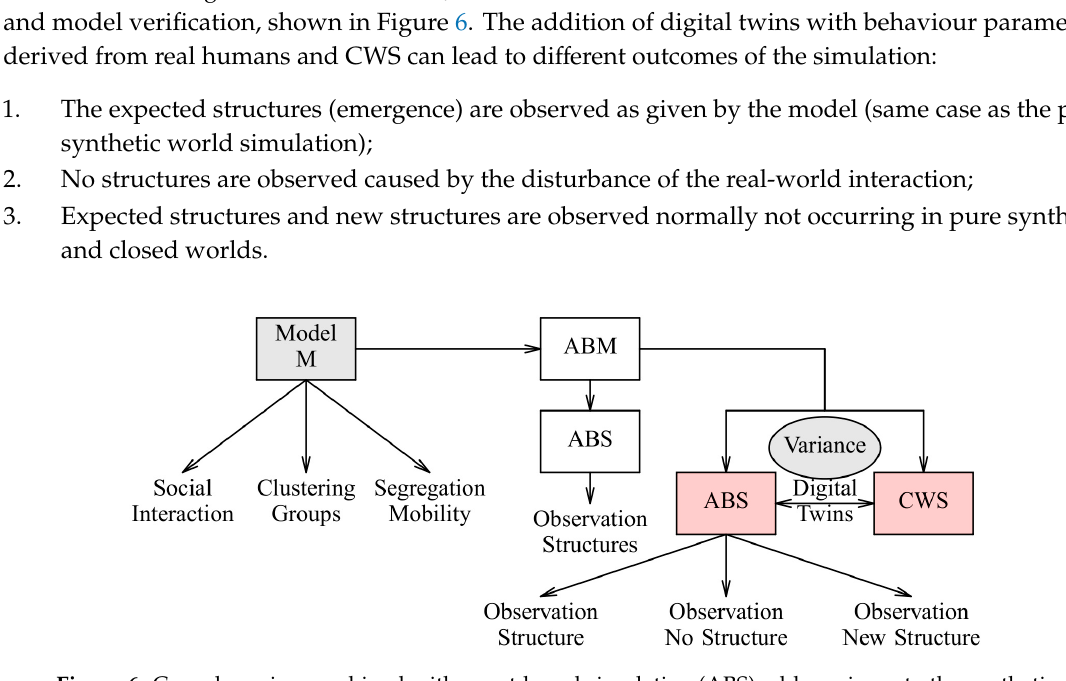
Figure 6. Crowd sensing combined with agent-based simulation (ABS) adds variance to the synthetic simulation world by digital twins.